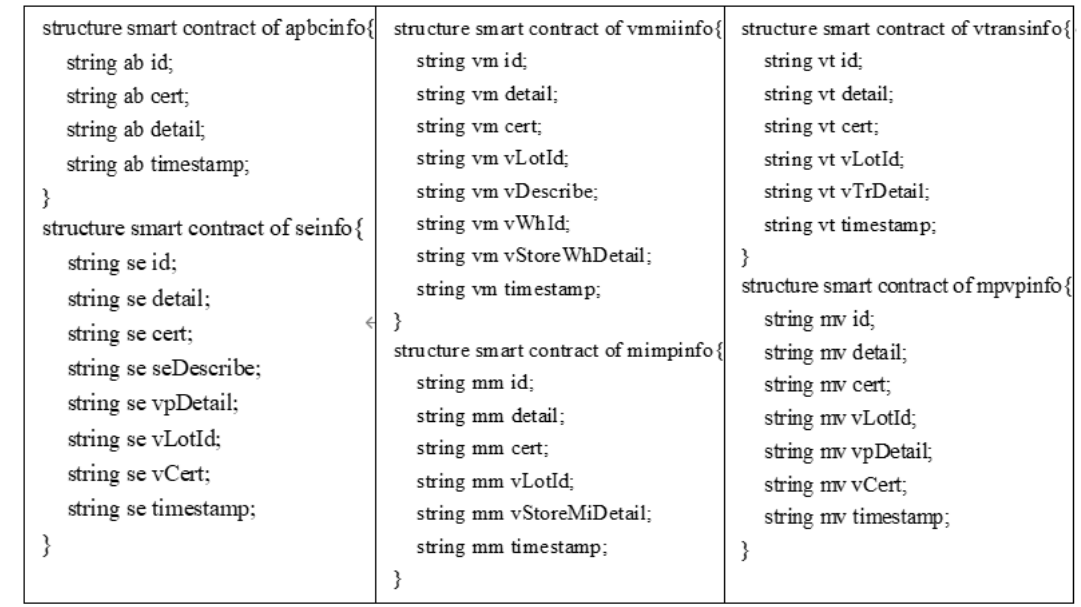
Figure 3. Smart contract structure of the scheme.